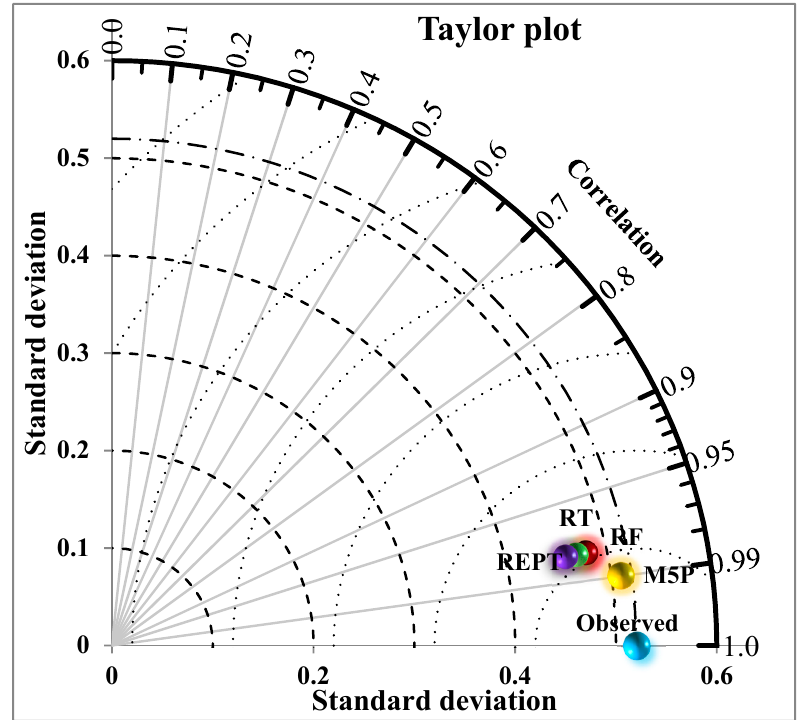
Figure 5. Taylor diagram of the models.